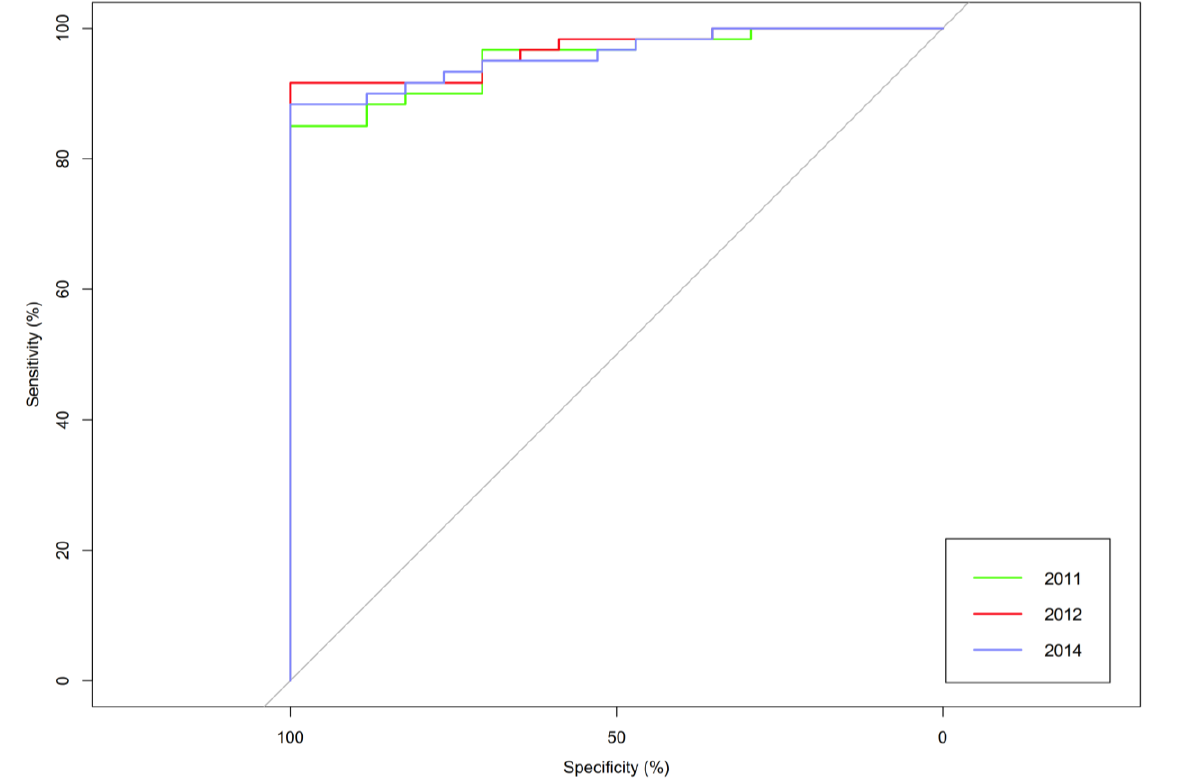
Figure 2. Statistical